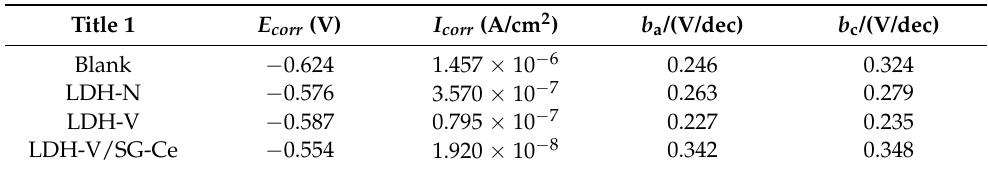
Figure 4. Potentiodynamic polarization curves for samples exposed in 3.5 wt.% NaCl solution. Table 1. Parameters of potentiodynamic polarization curves for samples exposed in 3.5 wt.% NaCl